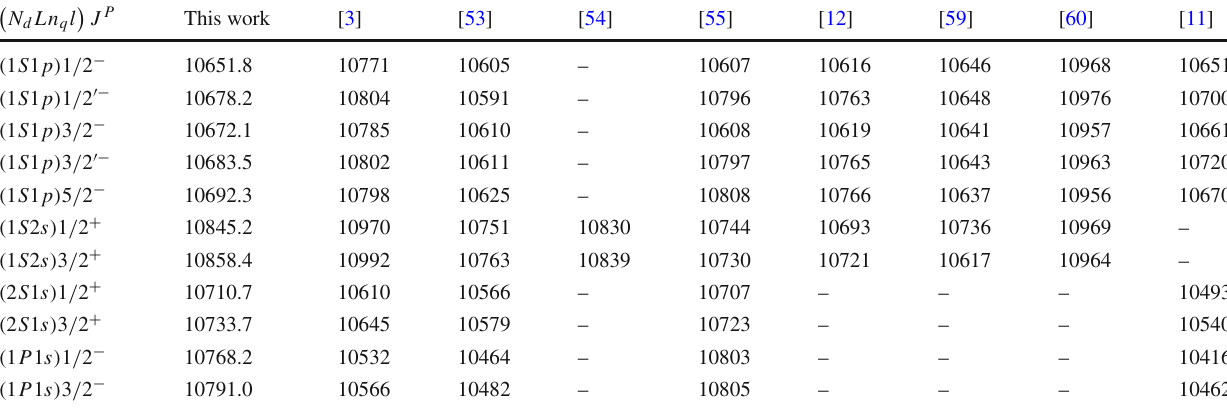
Table 14 Mass spectra of (cid:3) bb baryons (in MeV). Our results are obtained by the respective sum of the mean mass of the (cid:3) bb in Table 3, the binding energy shift(vanishes in 1S1s wave) in Table 9 and its splittings in Sect. 3 with the couplings given in Sect. 4